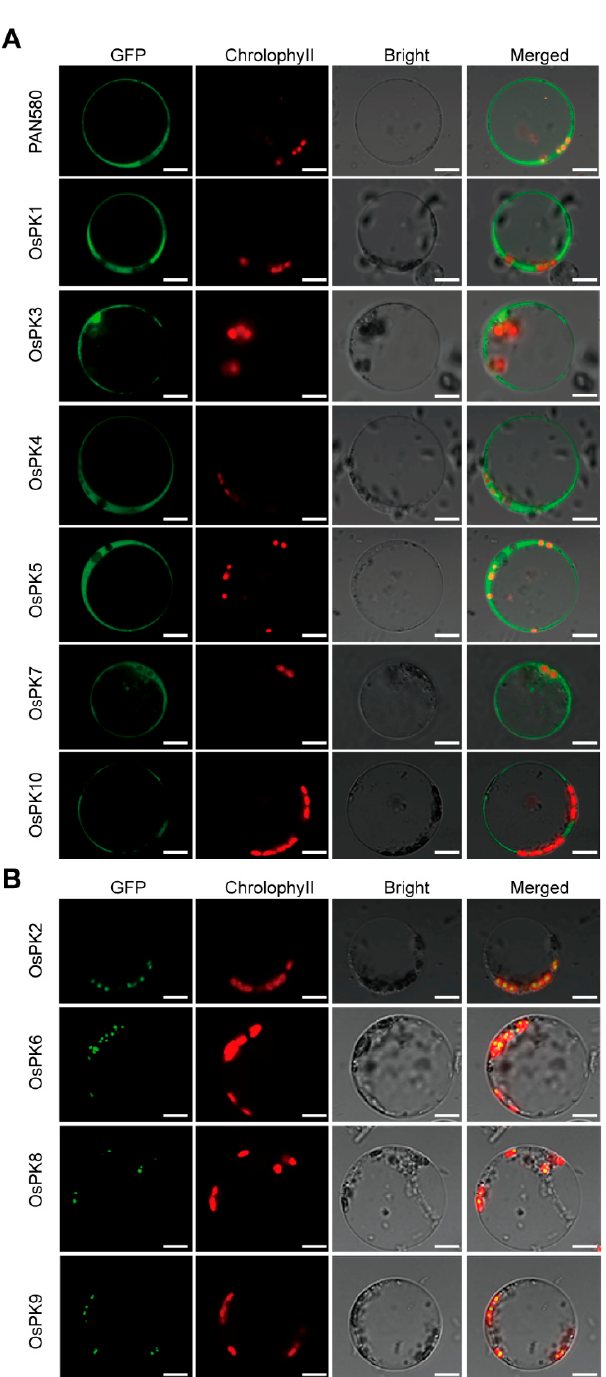
Figure 3. Subcellular localization of PKs in rice. ( A ) Transient expression of GFP, OsPK1-GFP, OsPK3-GFP, OsPK4-GFP, OsPK5-GFP, OsPK7-GFP, and OsPK10-GFP in rice protoplasts. ( B ) Transient expression of OsPK2-GFP, OsPK6-GFP, OsPK8-GFP, and OsPK9-GFP in rice protoplasts.